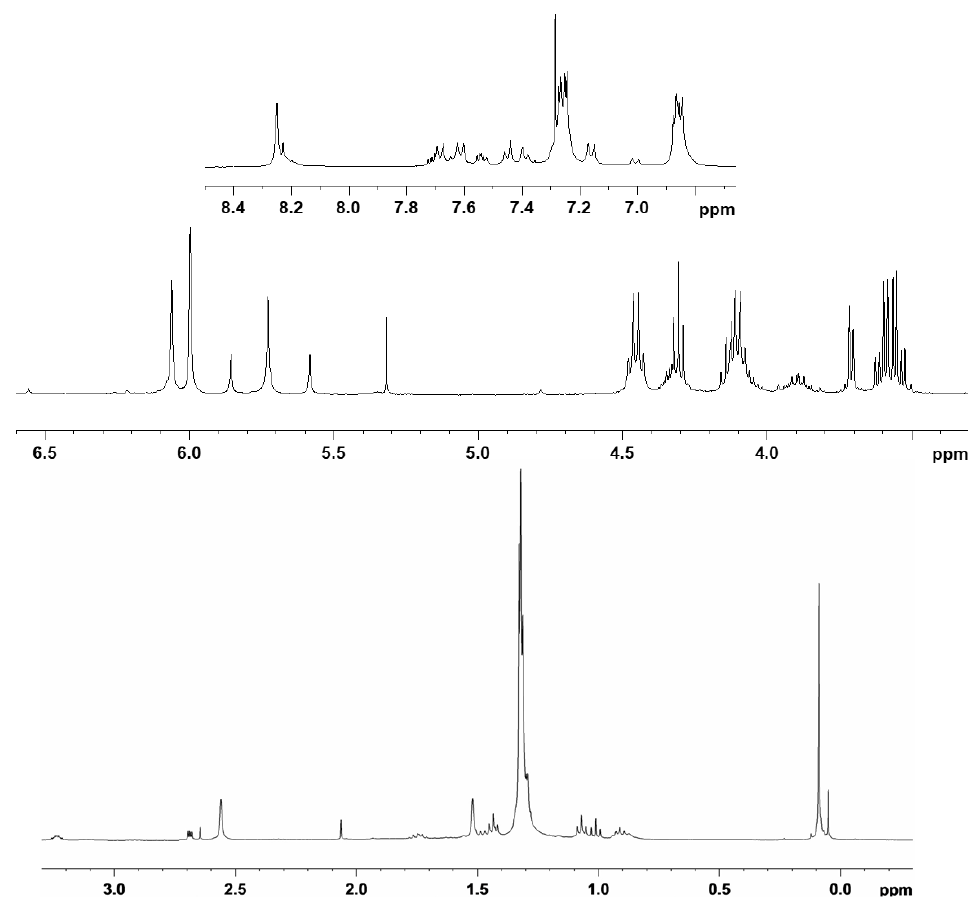
Figure 2. Expansions of 1 H NMR spectrum of C 70 -P-B in CDCl 3 .